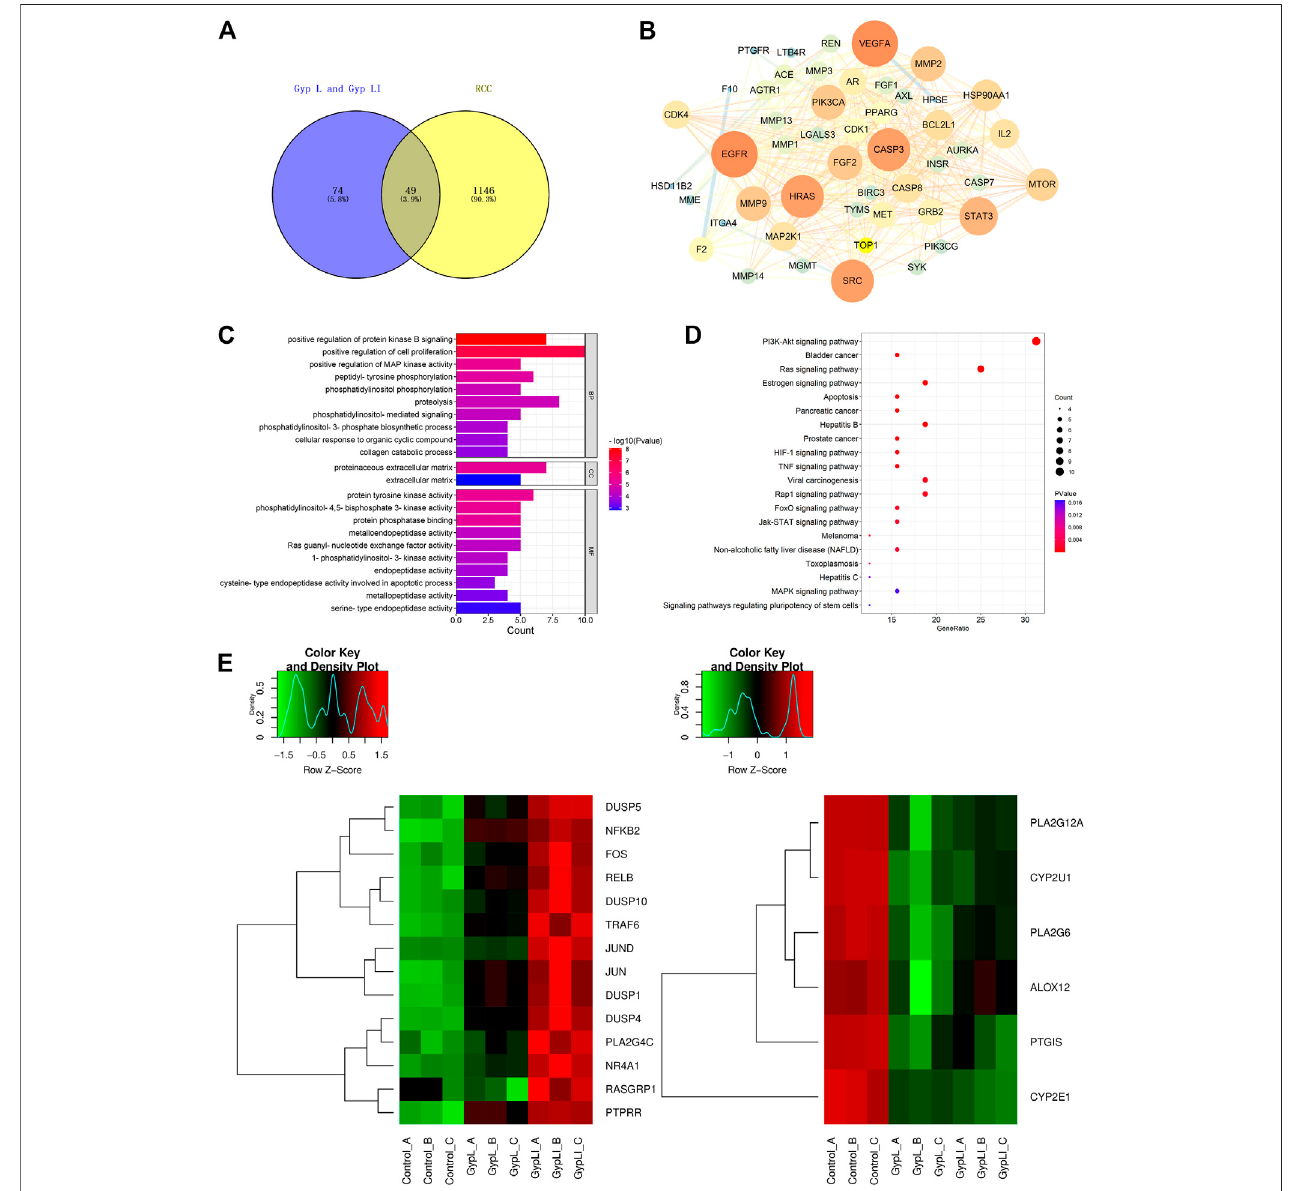
FIGURE3| AnalysesofthekeytargetsandpathwaysofGypLand GypLI inhibiting ccRCC cellsthrough networkpharmacologyand RNA-seq. (A) Venndiagram summarizing the intersection targets between Gyp L, Gyp LI, and renal cell carcinoma (RCC). (B) Protein interaction network diagram of 49 intersection targets was constructed through the cytoscape platform. (C) Gene ontology (GO) analysis of 49 targets in terms of biological processes, cell components, and molecular functions. (D) The KEGG pathway that Gyp L and Gyp LI affect the RCC process analyzed by R language. (E , F) Unsupervised hierarchical clustering of mitogen-activated protein kinase (MAPK) (E , F) arachidonic